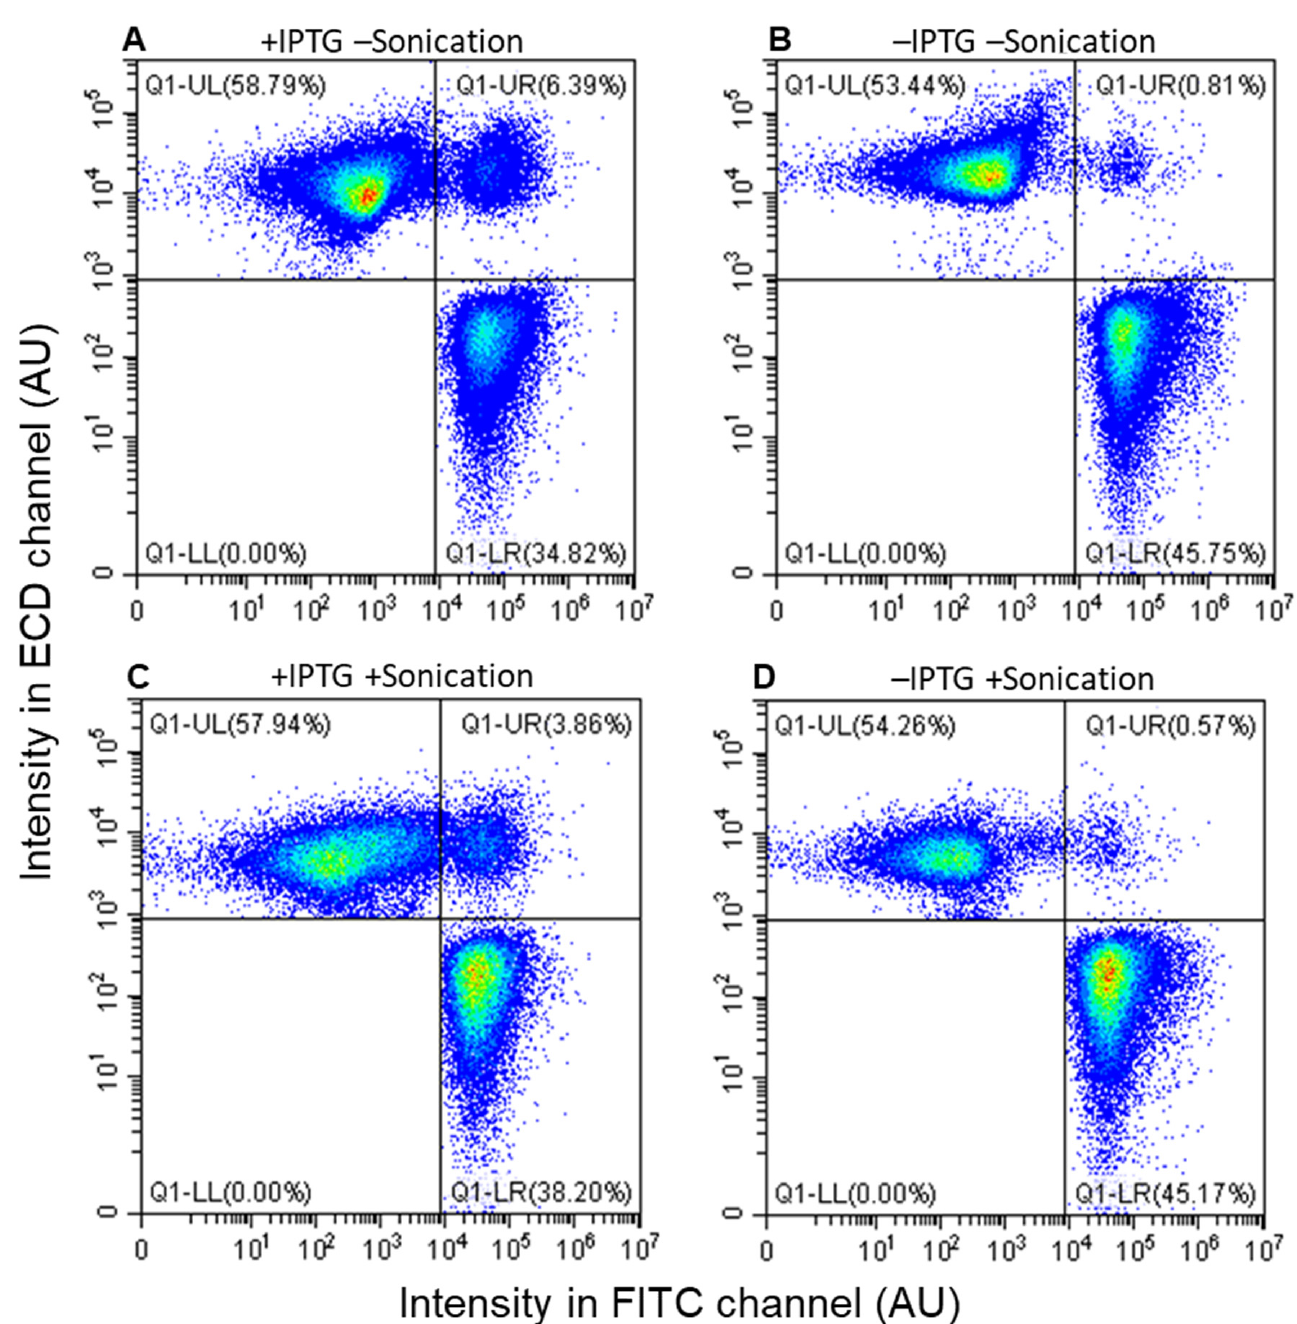
Figure 5. Two color plots after the mating between KV10 and KV11 cells. Mating was performed with ( A , C ) or without ( B , D ) IPTG, and then treated with ( C , D ) or without ( A , B ) a brief sonication. In response to the density of events, the heat map is set up so that the sparsest areas are blue, and as they become denser, the wavelength of visible light becomes longer from green, yellow, orange, and then to red. The experiments were repeated three times with similar results, and one set of representative plots is shown.